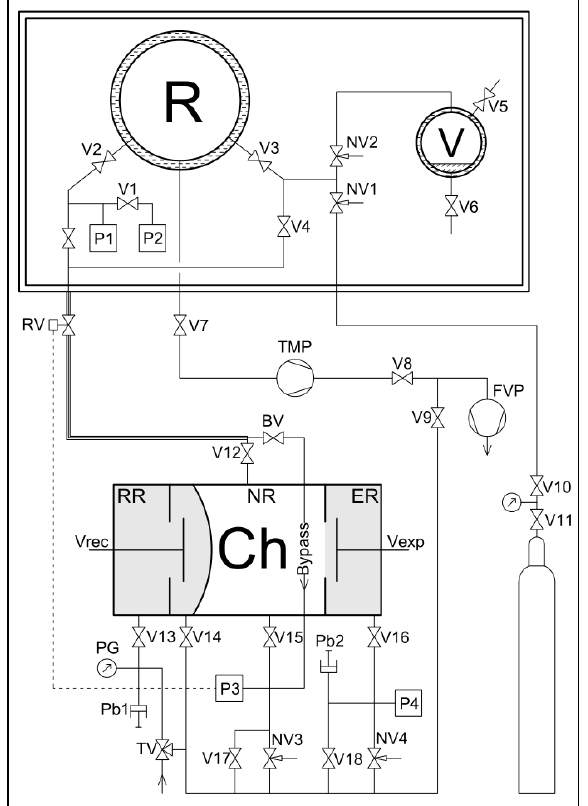
Fig.1. Schematic diagram of the homogenous nucleation setup: R – receptacle; V– vaporizer; TMP – turbomolecular pump; FVP – forevacuum pump; Ch – nucleation chamber; NR – nucleation reservoir; RR – recompression reservoir; ER – expansion reservoir; RV – electronically controlled regulation; Vx – valves; NVx – needle valves; BV - bypass valve; Vrec – recompression valve; Vexp – expansion valve; TV - three-way valve; PG – pressure gauge; Pbx – pump volume; Px – precision pressure transducers; dashed line – electric connection between regulating valve and pressure transducer in order to maintain the set